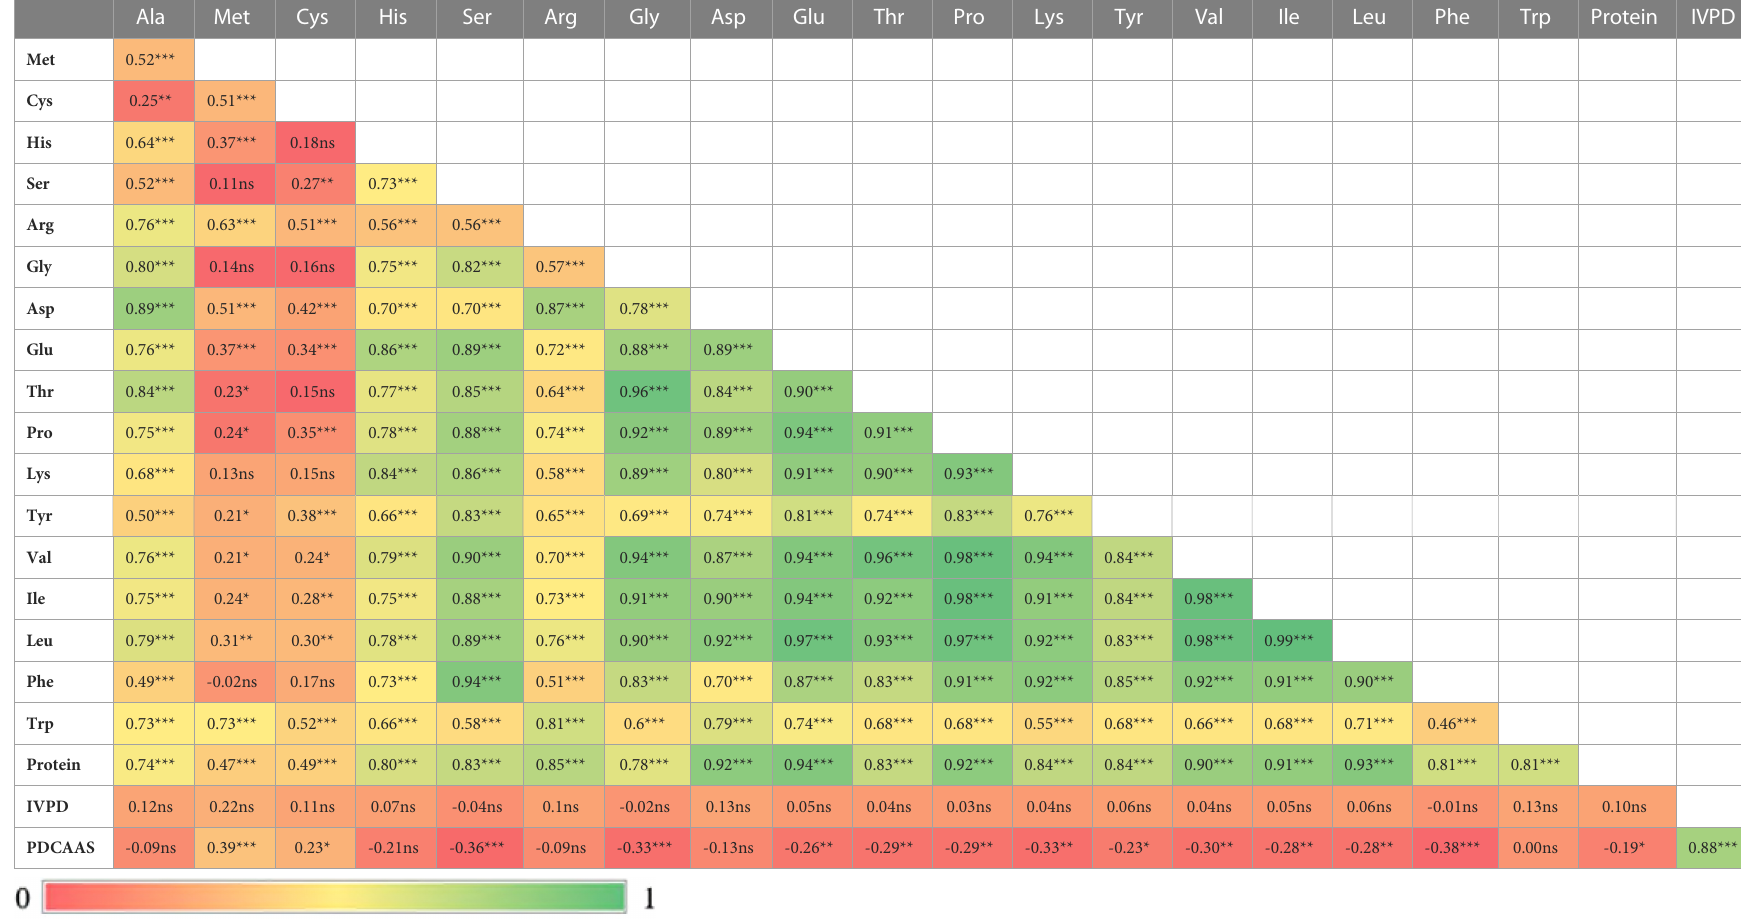
TABLE 3 Correlation analysis among total protein, protein digestibility ( in vitro ), PDCAAS and 18 amino acids found in pea seed.